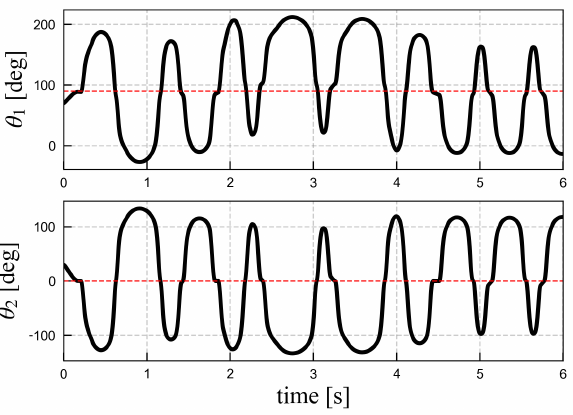
Figure 2. Swing-up-like motion: the dotted lines indicate the assumed coordinates values where the system should be